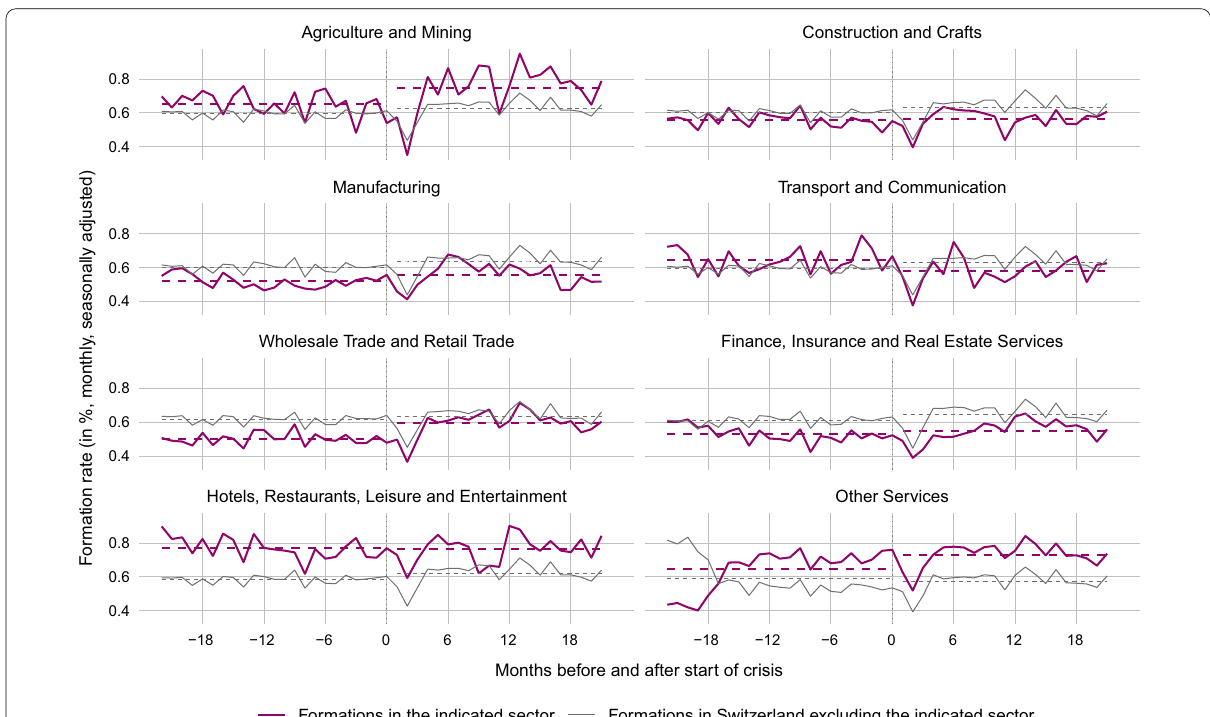
Fig. 21 Start-up rates in different sectors before and after start of COVID-19. Notes : The figure shows the monthly start-up rate ( seasonally adjusted frequency of new firm formations divided by the stock of firms) in the sectors of the Swiss economy before and after the start of the COVID-19 crisis as compared to the start-up rate in the respective rest of the economy. The last month before the crisis start ( February 2020. The dotted lines are the average bankruptcy rates over the 22 months before or after the crisis